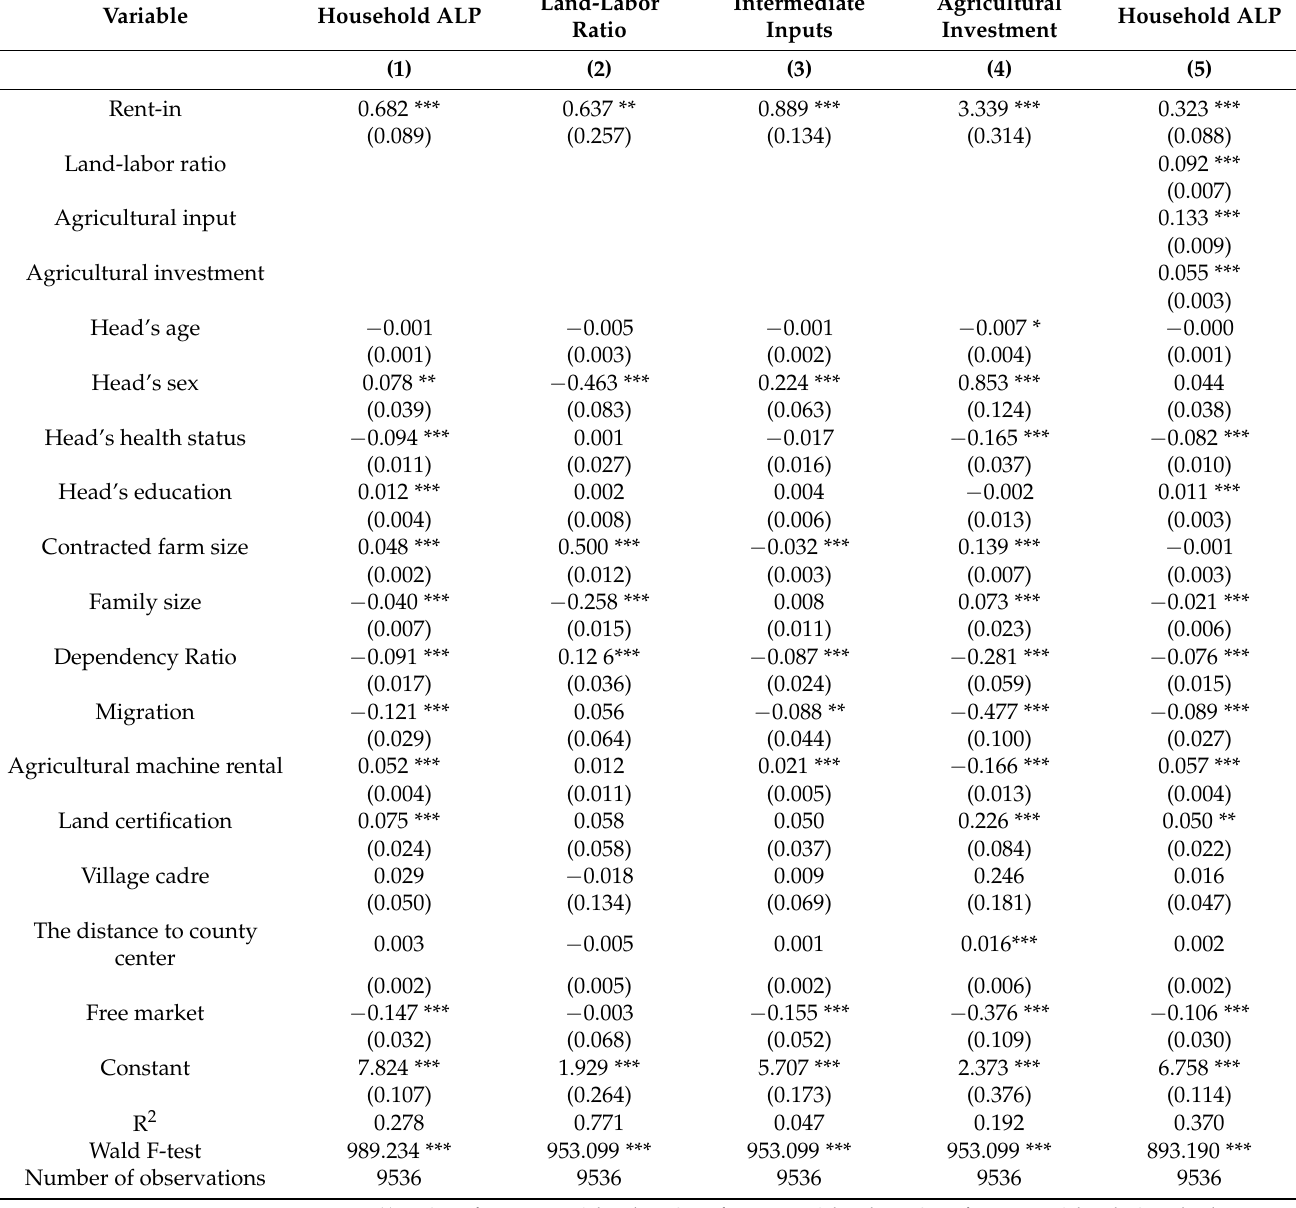
Table 5. The mediation analysis for improvement of household agricultural labor